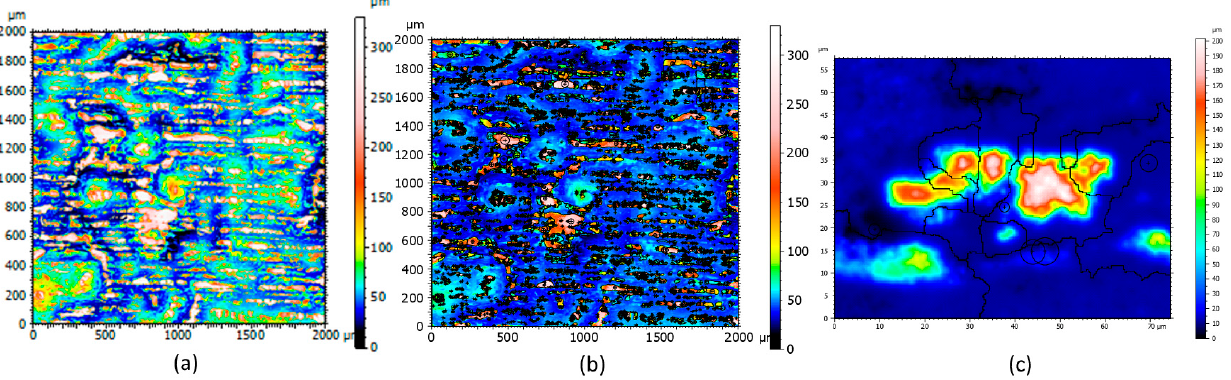
Figure 13. Topography measure of the sample N ◦ 10: ( a ) amplitude map, ( b ) Motifs decomposition, and ( c ) zoom of motifs.